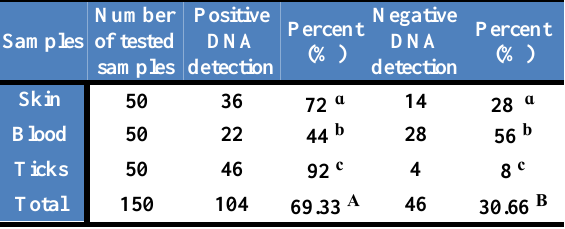
Figure, 1: Agarose gel electrophoresis image that show the PCR product analysis of P32 gene in lumpy skin disease. Where M: marker (1500-100 bp), lane (1-4) positive skin lesion samples, lane (5-7) positive blood samples, and lane (8-10) positive ticks samples, at 752 bp PCR product. Table, 1: Detection of LSDV DNA by conventional PCR in cattle.